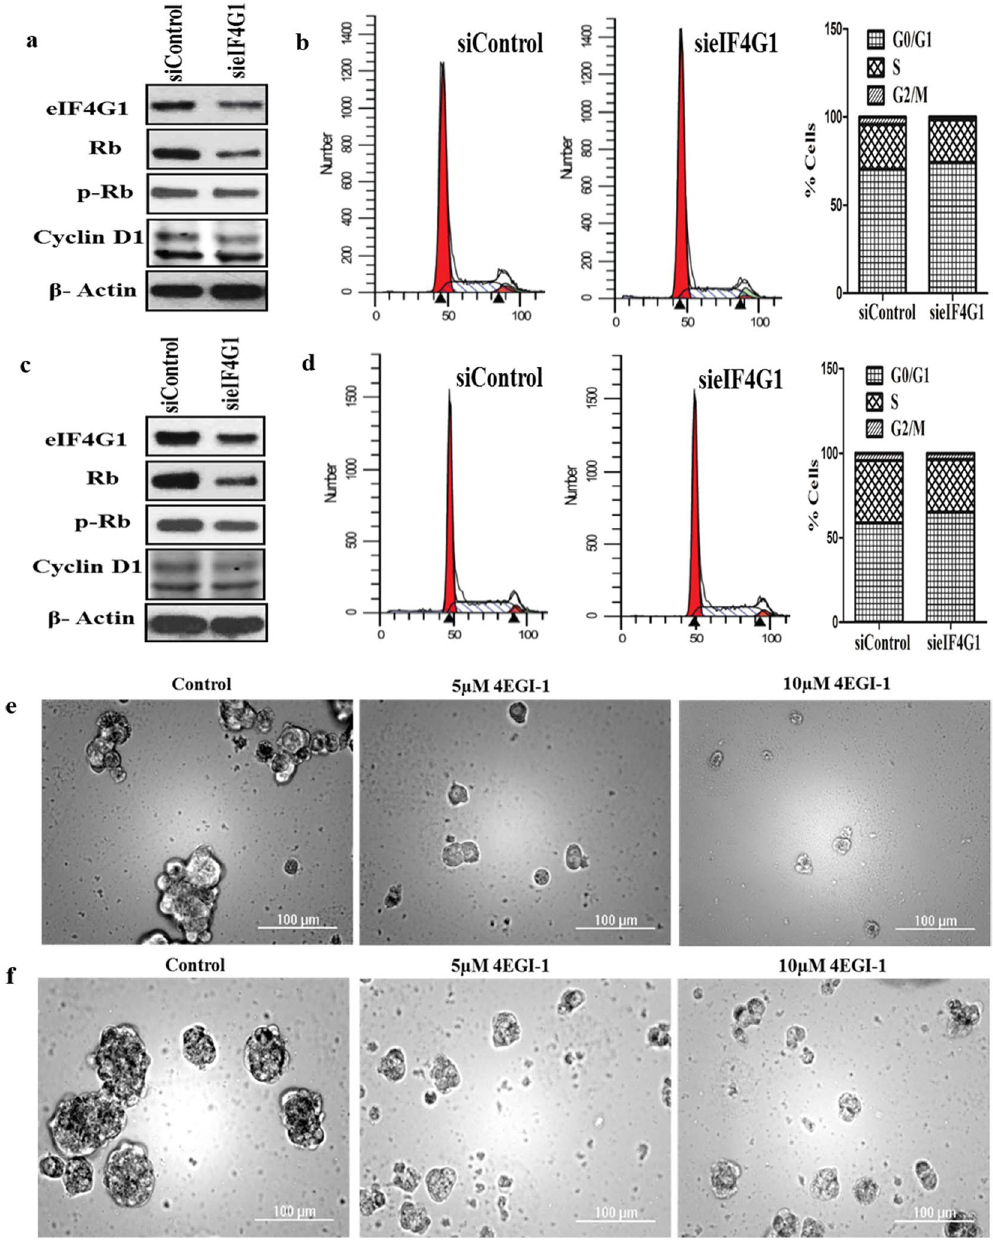
Figure 4. Knockdown of eIF4G1 reduces the levels of Cyclin D1, p-Rb, delays cell cycle and inhibitor of eIF4G complex impairs prostasphere formation: ( a ) Knockdown of eIF4G1 decreases Rb/p-Rb, Cyclin D1 protein levels and delays cells at the G0/G1 phase of cell cycle in LNCaP ( a , b ) and C4-2B ( c , d ). Adjacent is quantitation of cell cycle distribution in the different phase. ( e ). Representative images for prostasphere formation with control and treated with 5–10 µ M of 4EGI-1 (eIF4G-eIF4E complex inhibitor) for LNCaP ( e ) and CRPC cells (C4-2B cells) ( f